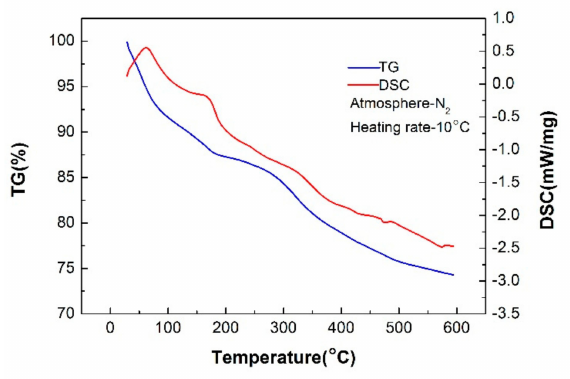
Figure 4. Thermogravimetric analysis (TG) and di ff erential scanning calorimetry (DSC) curves of